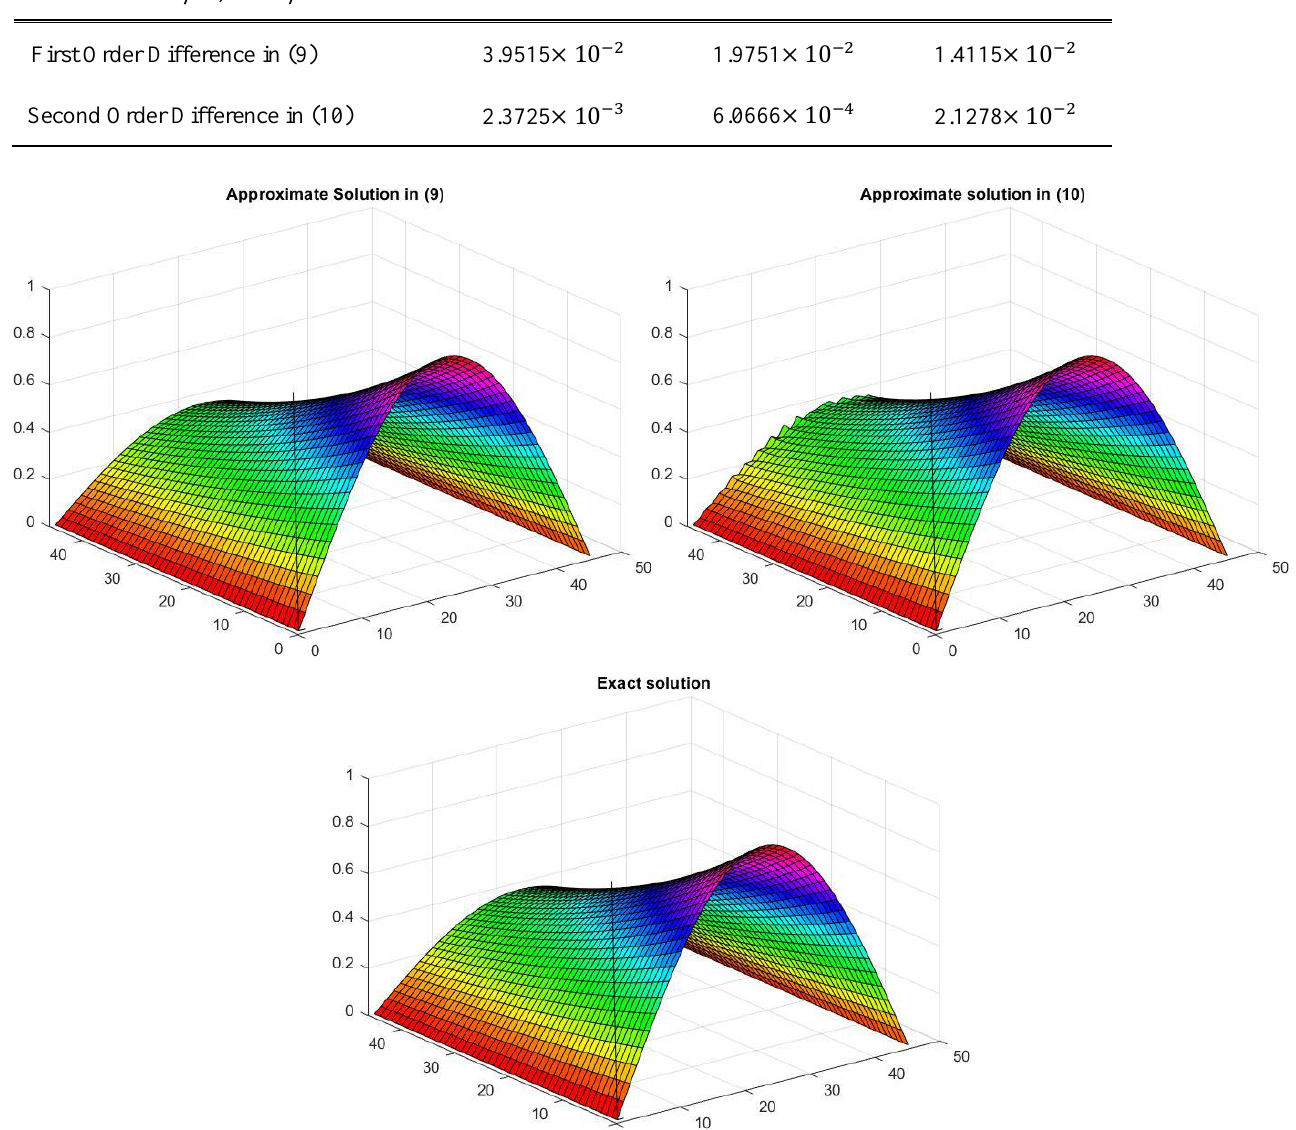
Table 1. Absolute Error for the Difference schemes in (9) and (10) in different values of N and M 𝒉 = 𝝅/𝑴, 𝝉 = 𝟏/𝑵